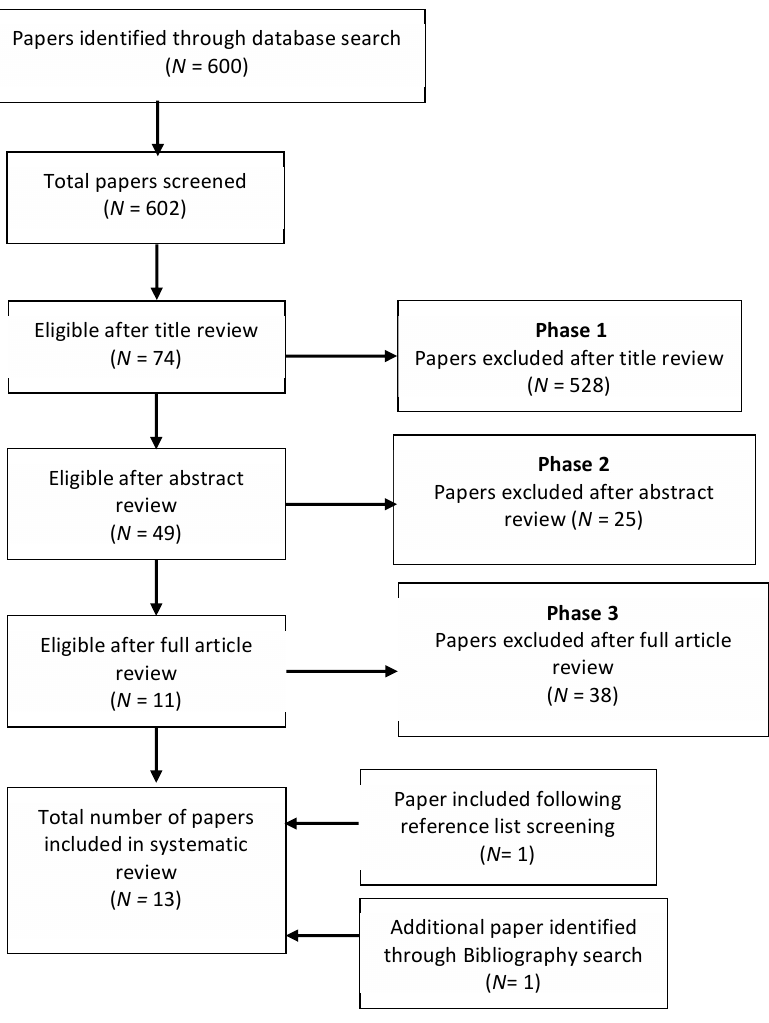
Figure 1. Identification of papers for systematic review.